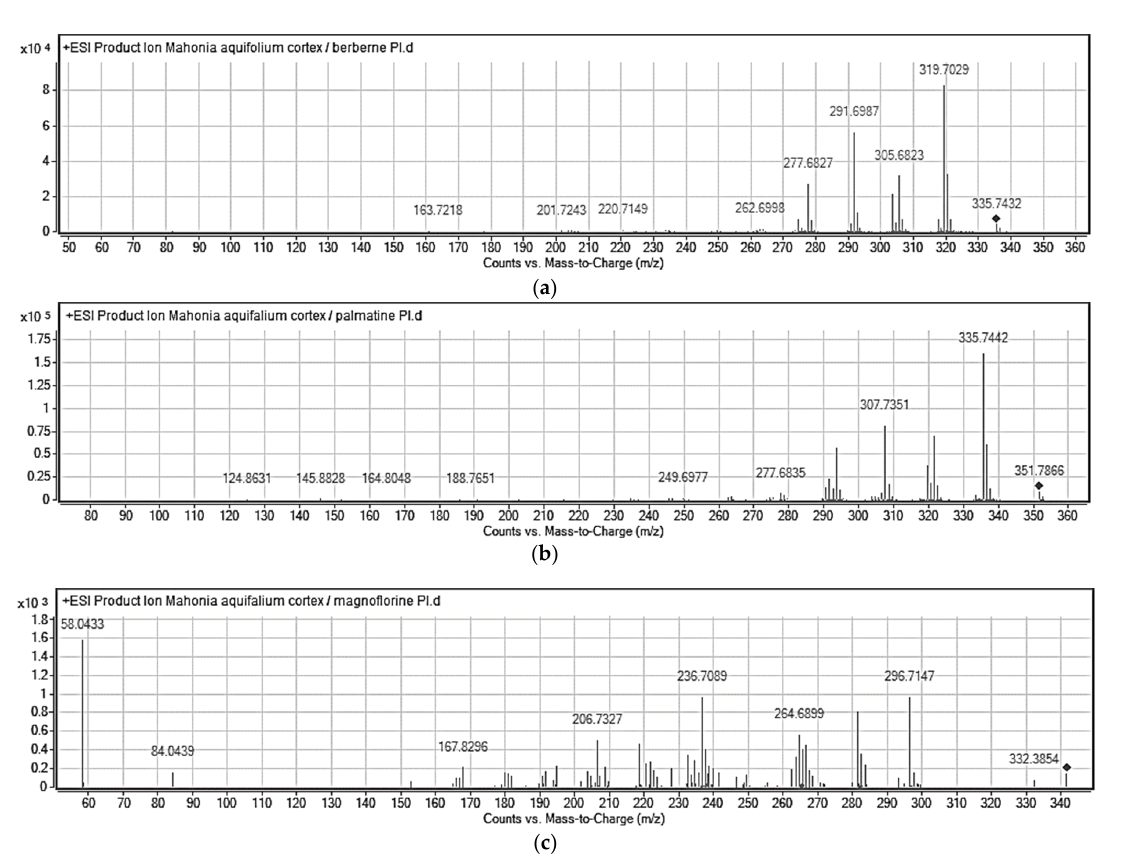
Figure 7. Representative product ion spectra MS/MS ( a – c ) for berberine (cortex), palmatine (root) and magnoflorine (cortex) obtained for studied isoquinoline alkaloids from Mahonia aquifolium extracts. Plant material collected during flowering. Mobile phase composition: v / v 0.1% HCOOH, 30% MeCN v / v . Experimental conditions: flow rate 0.6 mL/min, autosampler temperature 20 °C, drying gas flow rate 7.0 L/min; shielding gas flow rate 5.0 L/min; nebulizer gas pressure 40 psi; skimmer voltage 50 V, octopole voltage 800 V; capillary voltage 3500 V; drying gas temperature 295 ◦ C; shielding gas temperature 315 °C; fragmentor voltage 195 V; CID energy in both MS and MS/MS were 5 and 20 eV.